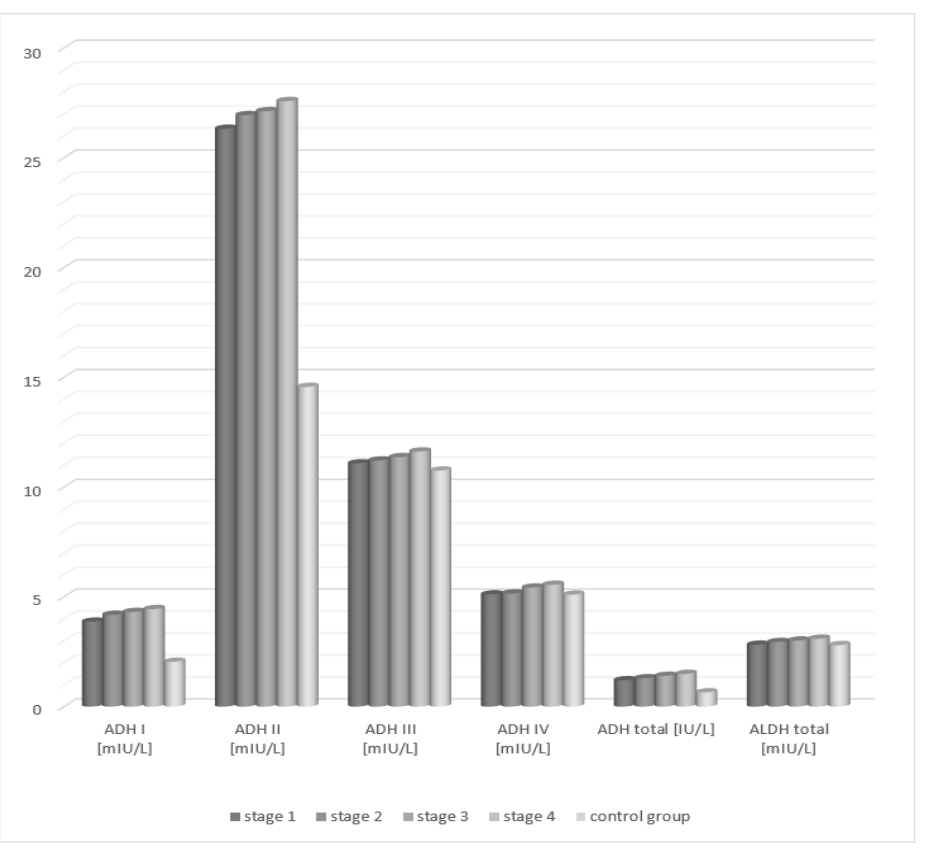
Figure 2. Activity of ADH and ALDH in the serum of patients with alcoholic fatty liver depending on the degree of cirrhosis in accordance with the METAVIR classification.